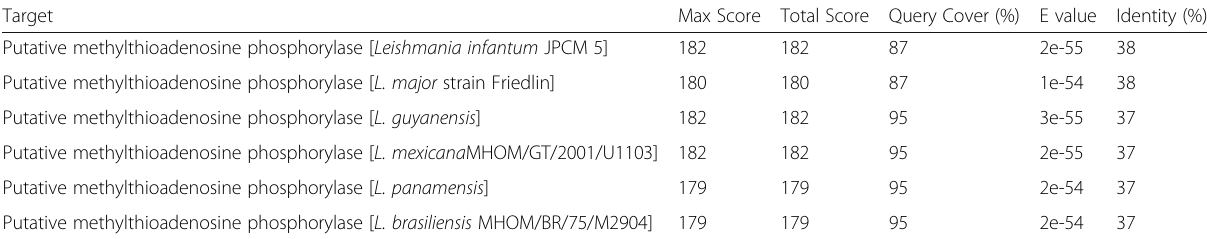
Table 4 BLAST results for Leishmania sp protein sequences producing significant alignment with human S-methyl-5-thioadenosine phosphorylase